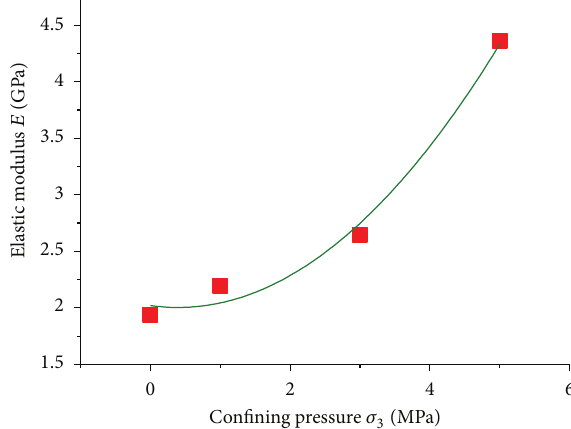
Figure 10: Changes of strengths of mudstone and coal with different confining pressures.